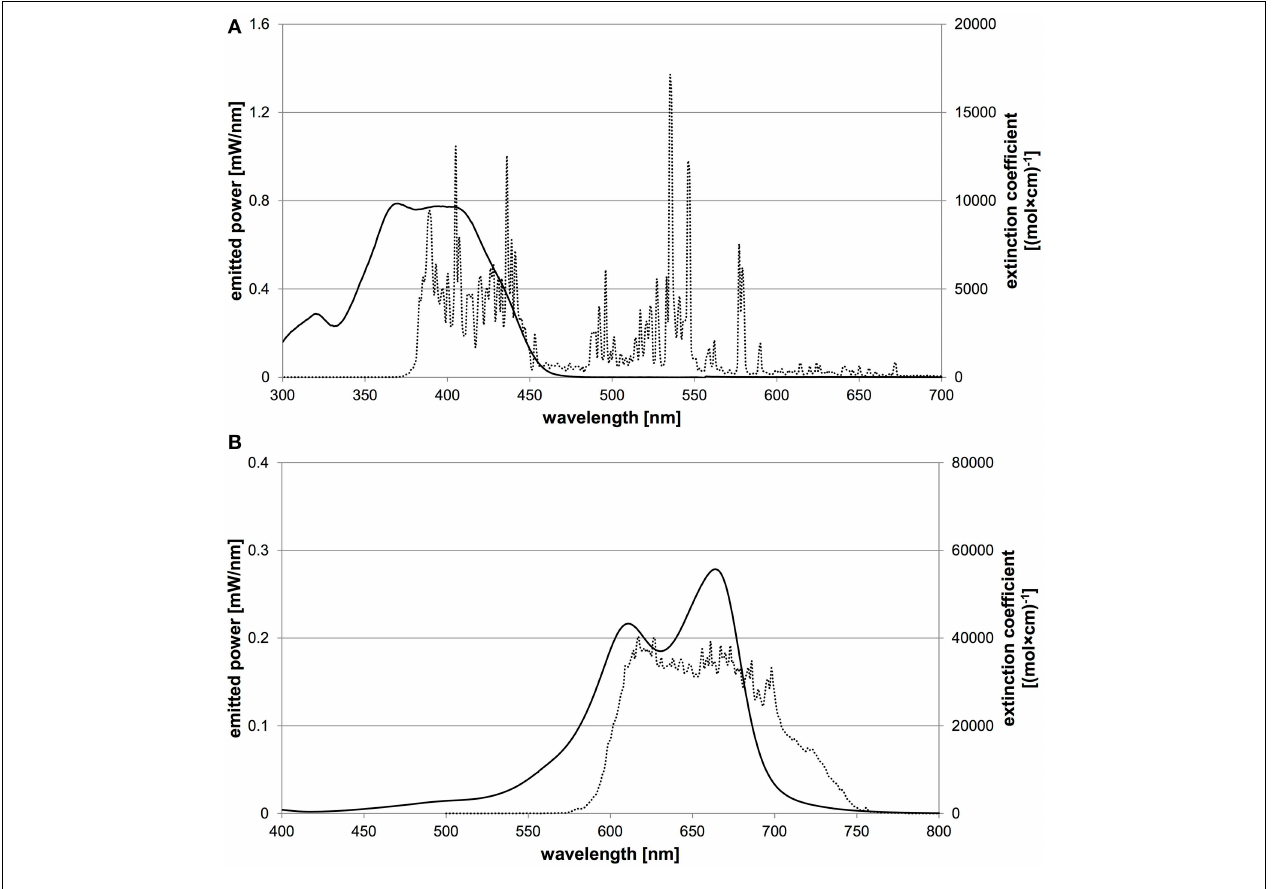
FIGURE 2 | Characteristic absorption spectra of both PS and emission spectra of corresponding light sources. The abscissa shows the wavelength in nm, the left ordinate the spectral radiant power of the light source and the right ordinate the extinction coefficient of the PS.